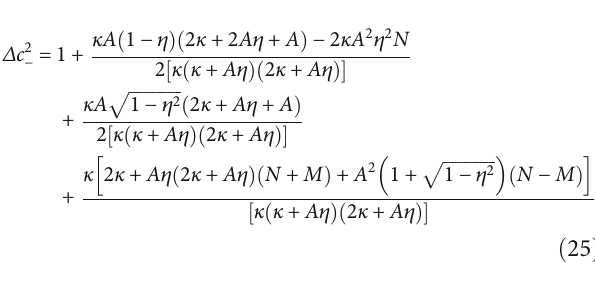
ffiffiffiffiffiffiffiffiffiffiffiffi p 1 − η 2